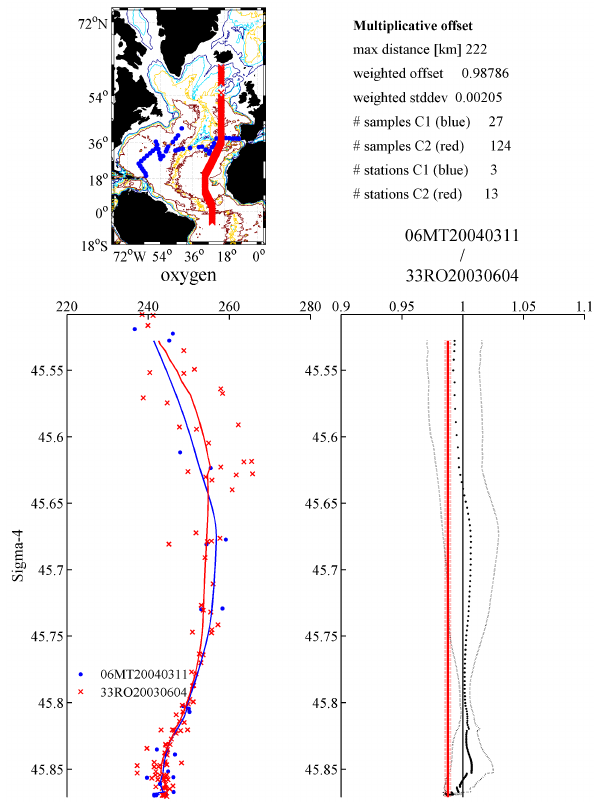
Figure 2. An example of a typical crossover made for oxygen in the eastern North Atlantic made by the running-cluster